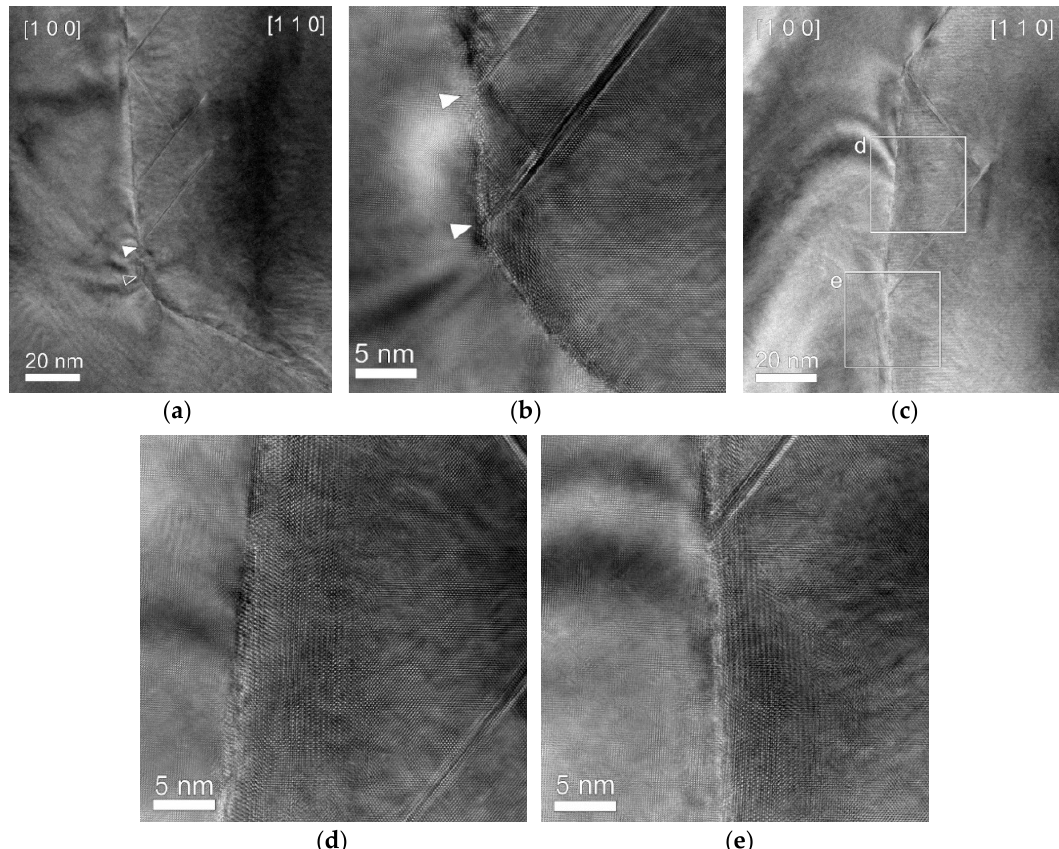
Figure 4. ( a ) Low-magnification image of stacking faults (SFs) pinning the GB and ( b ) enlarged view of ( a ). A SF shown in ( b ) is missing in ( a ), which was taken after ( b ). ( c ) low-magnification image of SFs in another region. ( d ) and ( e ) enlarged views of boxed regions marked as d and e in ( c ).